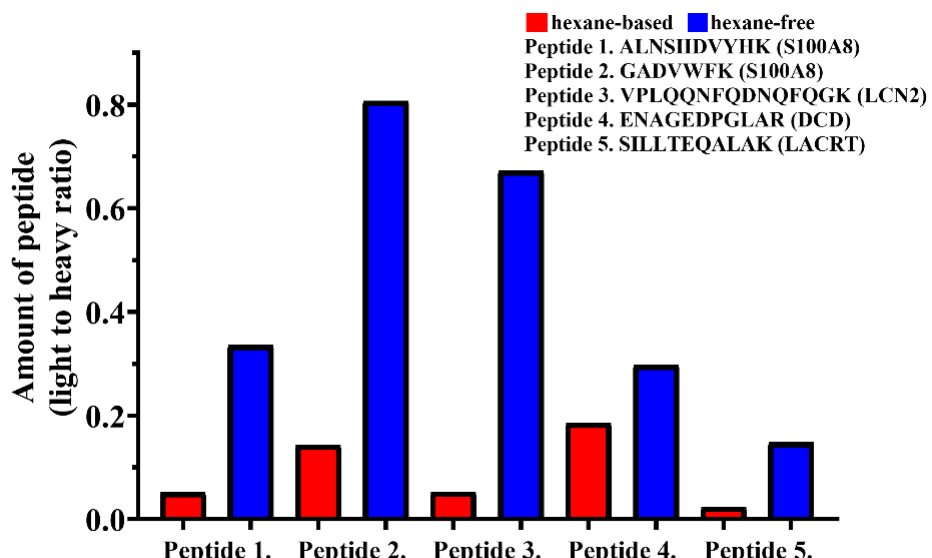
Figure 2. Comparison of the amounts of the selected peptides following a hexane-based or a hexane-free peptide elution. On the ‘y’ axis the number of peptides expressed in form of light to heavy ratios observed in case of examined peptides is plotted. The red bars represent the ratios observed in case of samples obtained by hexane-based elution, while the blue bars show the values observed in case of hexane-free elution.